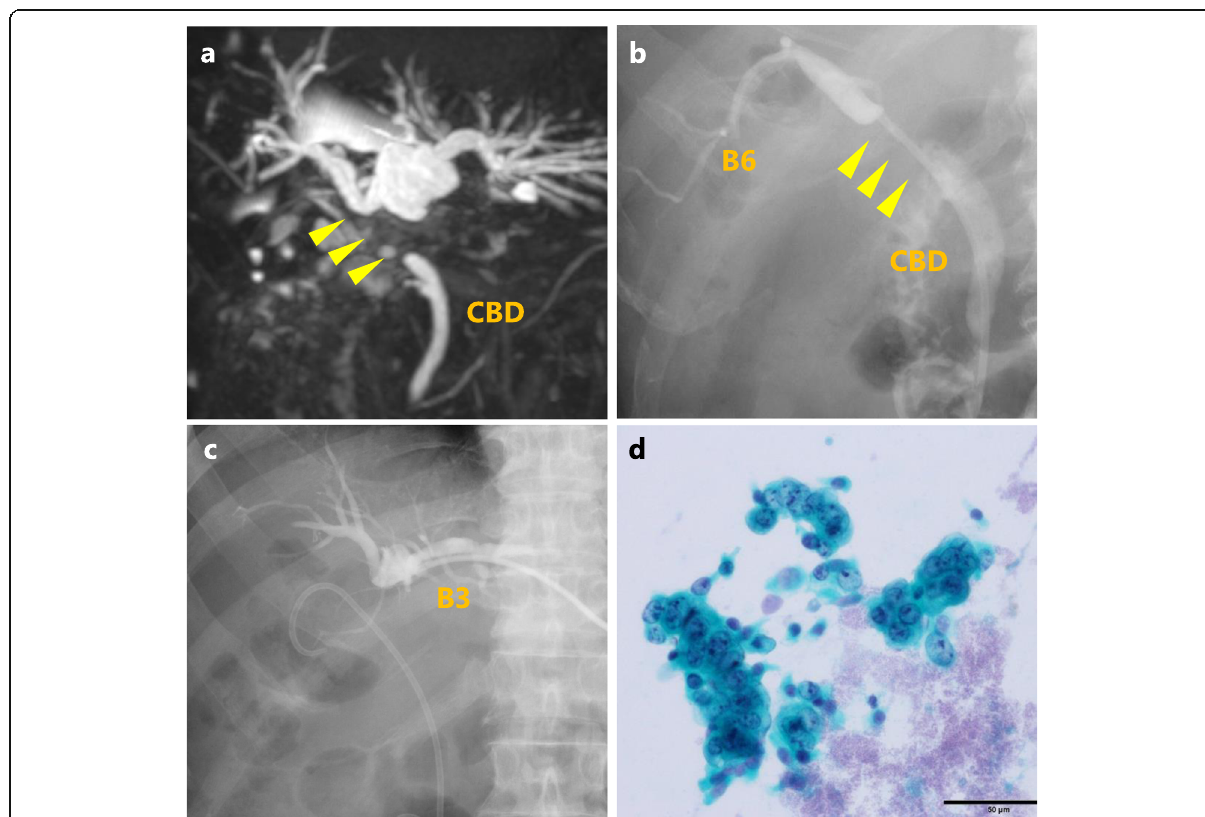
Fig. 2 Images of the bile stricture. a MRCP showing a hilar bile duct stricture (yellow arrowheads). b Endoscopic biliary stent placed in the right posterior inferior bile duct (B6). c Percutaneous transhepatic biliary drainage into the left lateral anterior bile duct (B3). d Aspiration bile cytology from the PTBD showing malignant cells. MRCP, magnetic resonance cholangiopancreatography; CBD, common bile duct; PTBD, percutaneous